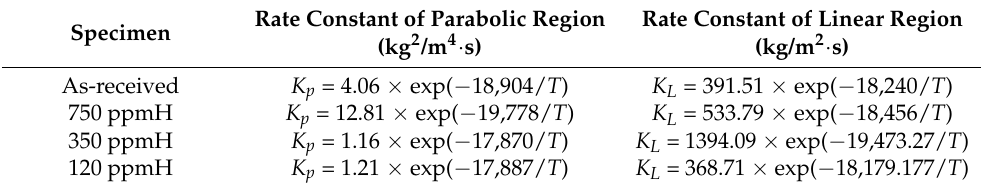
Table 3. Rate constant equations for the Zircaloy-4 cladding oxidized in air at temperatures between 500 and 800 ◦